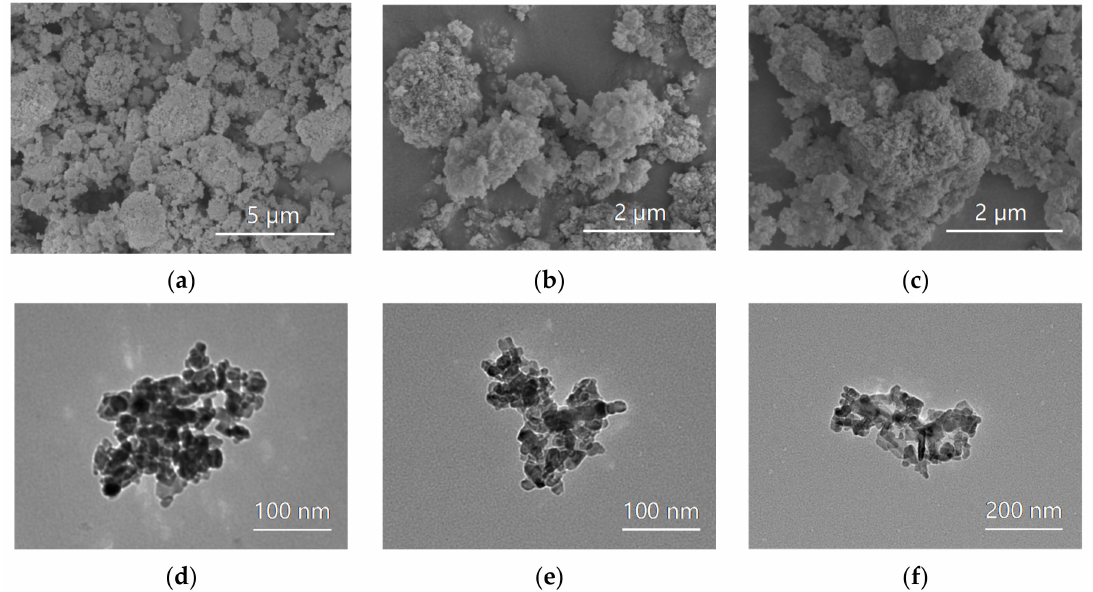
Figure 3. SEM images of the ( a ) non-modified ( b ) hydrophilic modified and ( c ) hydrophobic modified Al 2 O 3 nanoparticles and TEM images of the ( d ) non-modified ( e ) hydrophilic modified and ( f ) hydrophobic modified Al 2 O 3